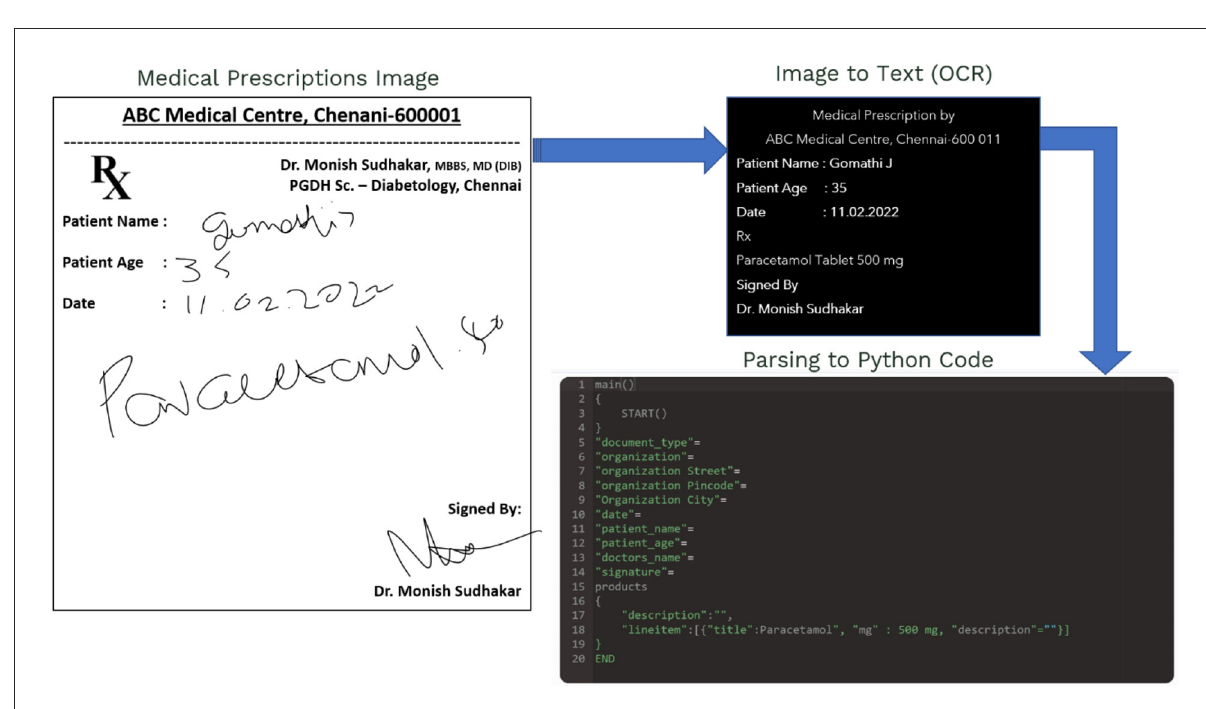
FIGURE7 Cropping and generating random patches of MedIMG.